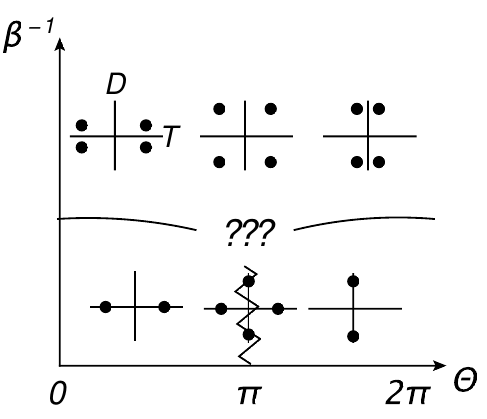
Figure 2 . The phase diagram in figure 1 is independent of additional gauging. Here we add the vacua in the various regions after gauging as in the mixed gauge theory.